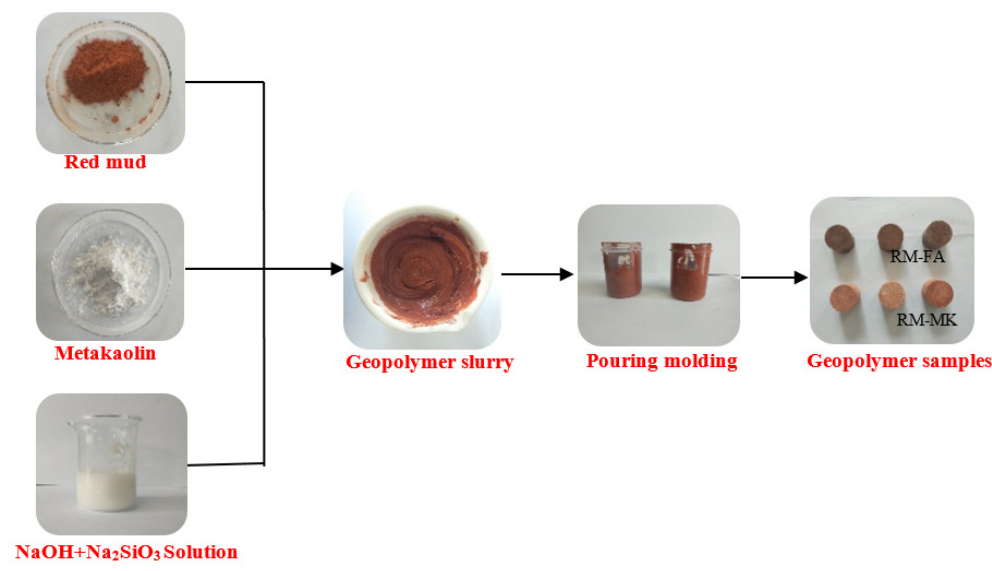
Figure 2. The preparation process of the geopolymer.